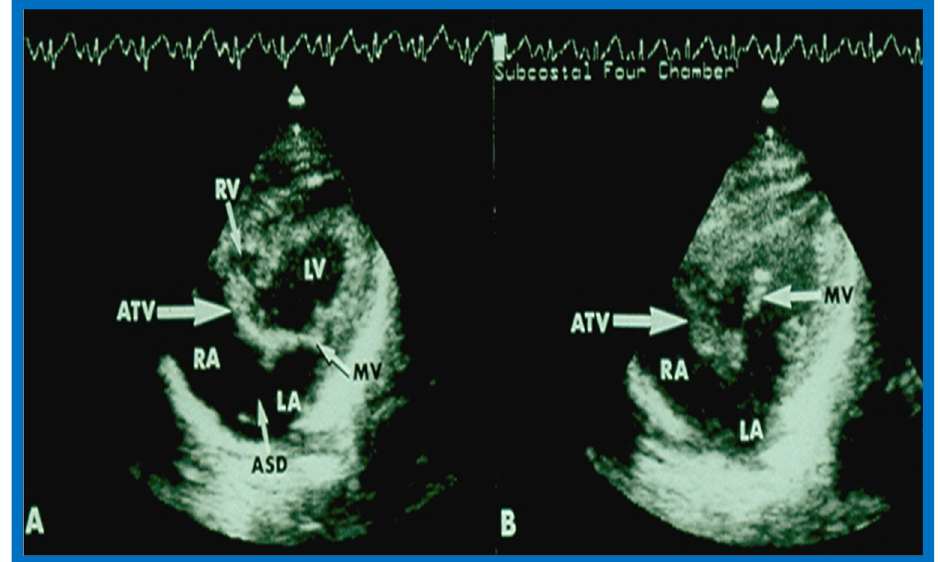
Figure 15. Selected video frames from subcostal four-chamber view of a two-dimensional (2-D) echocardiographic study demonstrating atretic tricuspid valve (ATV) (thick arrow), represented by a dense band of echoes between the right atrium (RA) and hypoplastic right ventricle (RV). In ( A ), the mitral valve (MV) is closed, while in ( B ), it is open. Note the improvement from the pictures shown in Figure 14. LA, left atrium; LV, left ventricle. Reproduced from Rao P.S. [35].